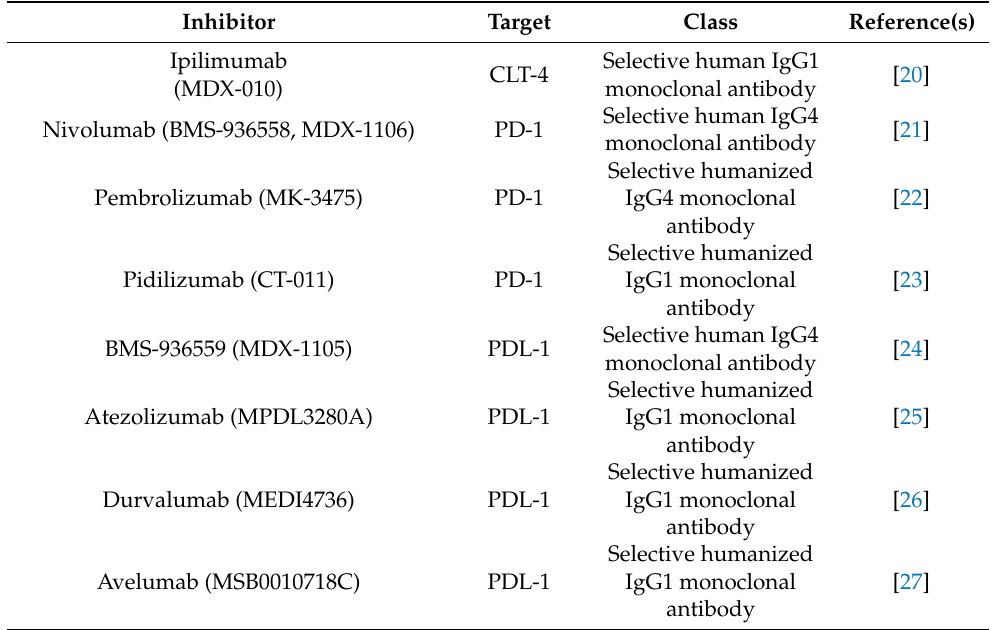
Table 1. Schematic representation of the principal melanoma immunotherapeutic